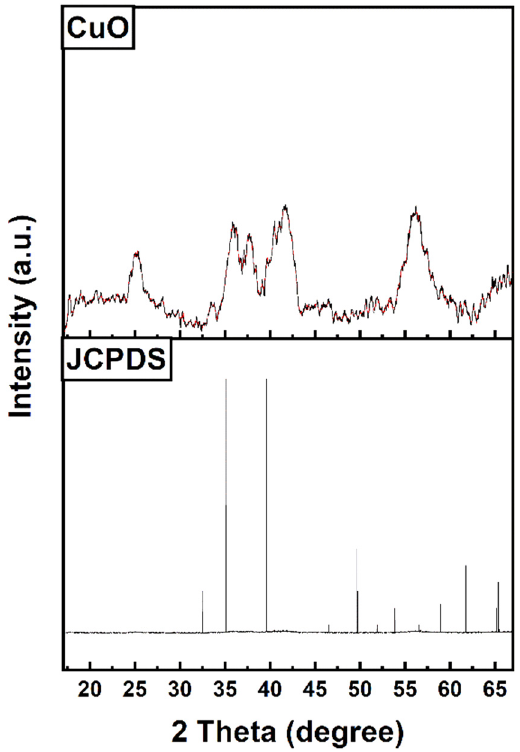
Figure 5: Comparison of XRD Patterns of CuO sample and 05 - 0661 JCPDS XRD β - CuO - NPS Reference Standard [ 16 ]